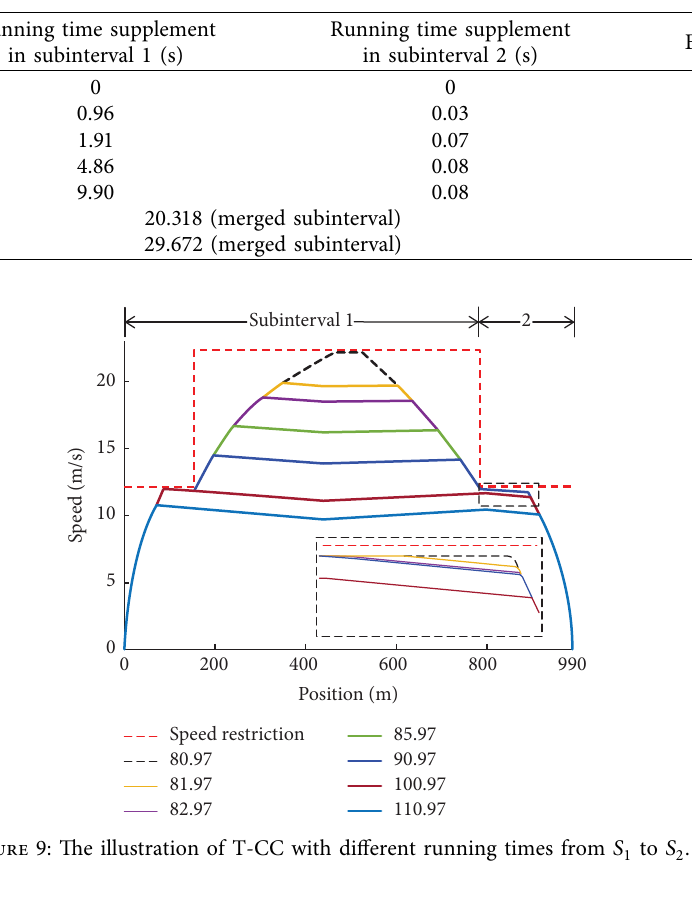
Table 5: Te comparison of T-CC with diferent running times from S